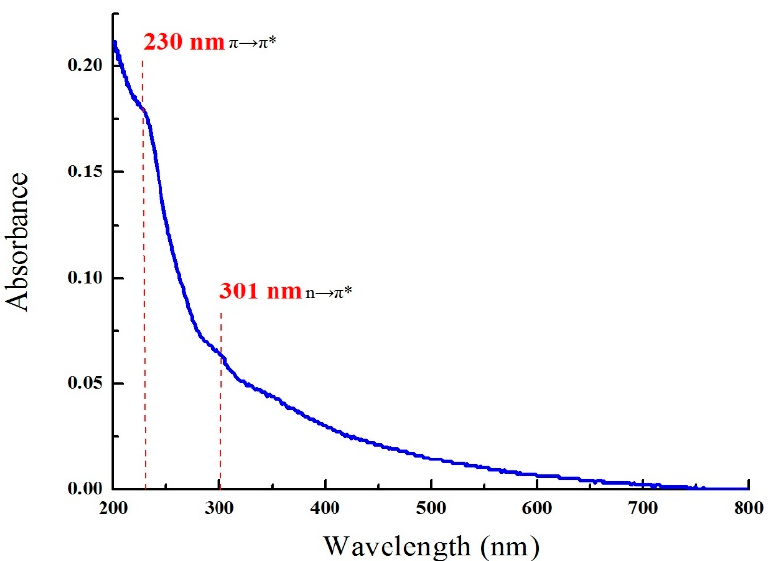
Figure 3. UV-Visible spectrum curve of the aqueous solution of GO nanosheets (0.0023g GO in 4.5 mL distilled H 2 O).